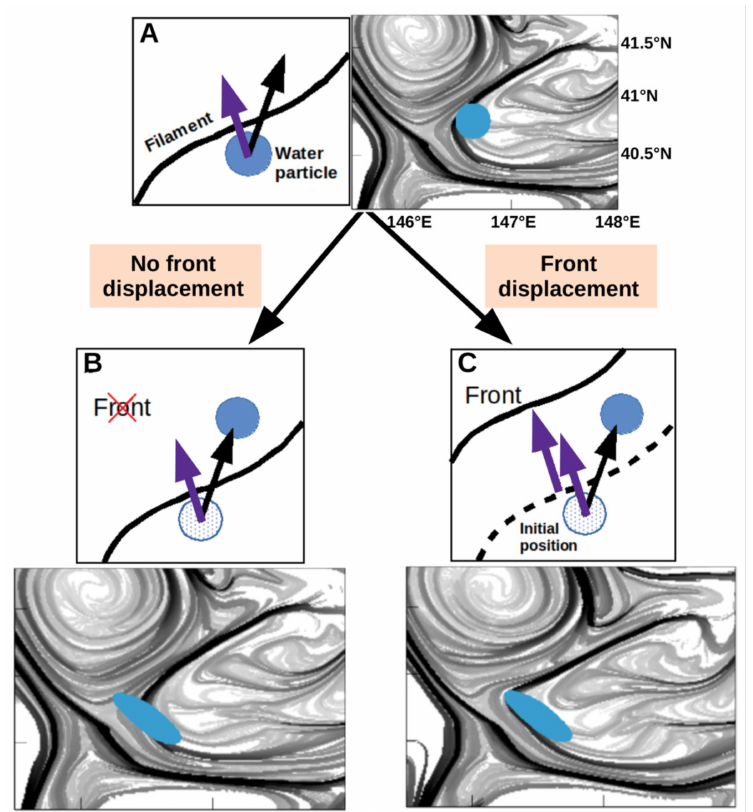
Figure 6. A sketch resuming the method used for the short-term prediction of front drifting presented in this paper. Panel ( A ) represents the starting position of a water mass (filled blue patch). Panel ( A , C ) show the new position of the same water mass (filled blue patch) after a few days. The old position is reported as a hashed circle. Assuming that the water flux is negligible across a Lagrangian front (black line in panel ( A )), the front should move as the water particle drifts with a speed (purple arrow) directed across and orthogonal to the front. Otherwise, the water particle crosses the filament, which will no longer be considered as a well-defined front or transport barrier (panel ( B ) and the associated FSLE map). The front drifting speed is represented by the purple arrow in panel ( C ) in which the dashed line defines the initial position of the front before its movement. The continuous black arrow in all panels corresponds to the altimetry-derived velocity vector. Panels are accompanied by examples of FSLE showing the need for the front to drift in order to conserve its characteristic as a transport barrier. By drifting, the front prevents the cross-frontal passage of the blue water mass, as shown in the FSLE map accompanying panel ( C